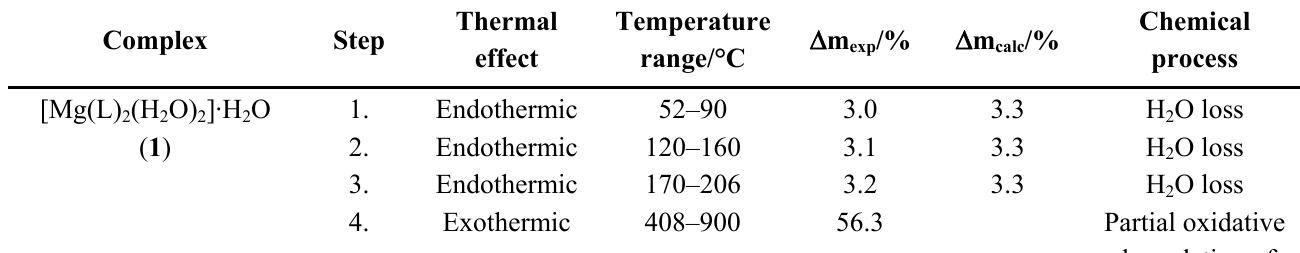
Table 8. Thermal degradation data (in synthetic air) for the complexes.